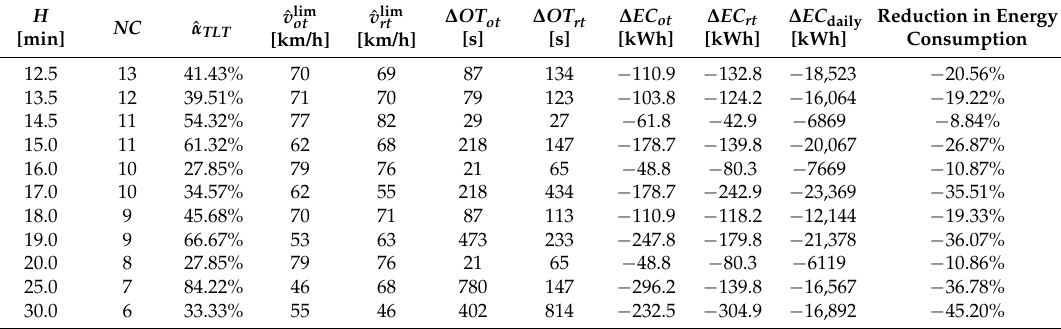
Table 6. Energy saving optimization in the case of 95th percentile.